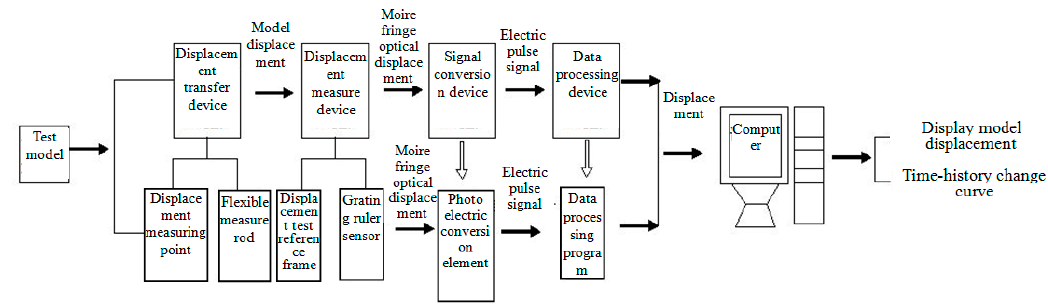
Figure 6. Workflow diagram of an automatic model displacement test system.